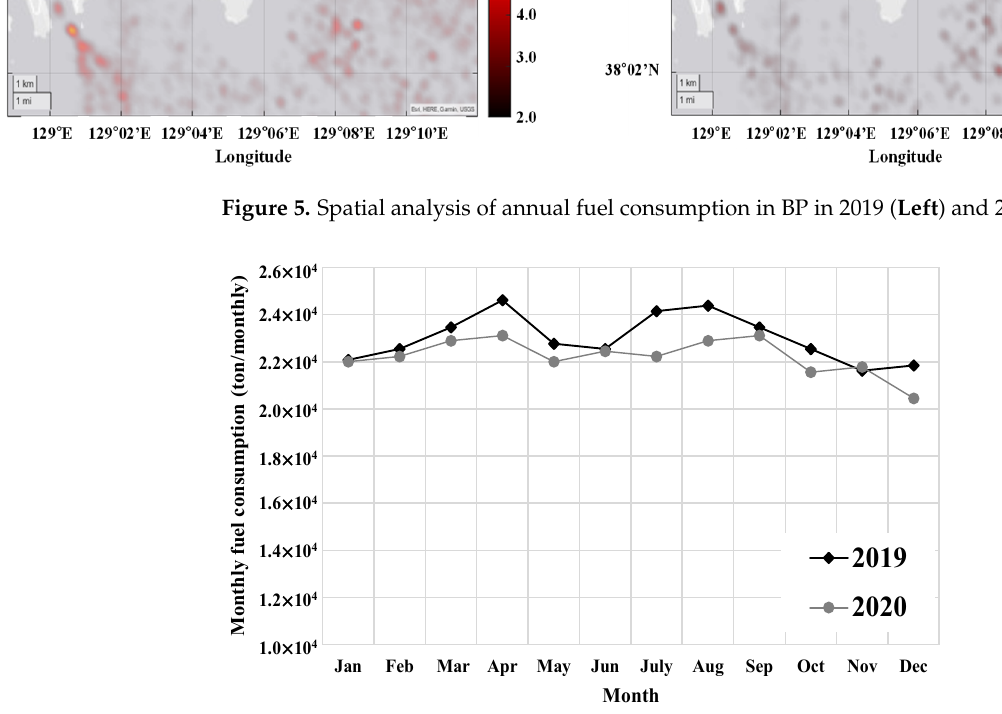
Figure 6. Monthly fuel consumption in BP in 2019 and 2020.